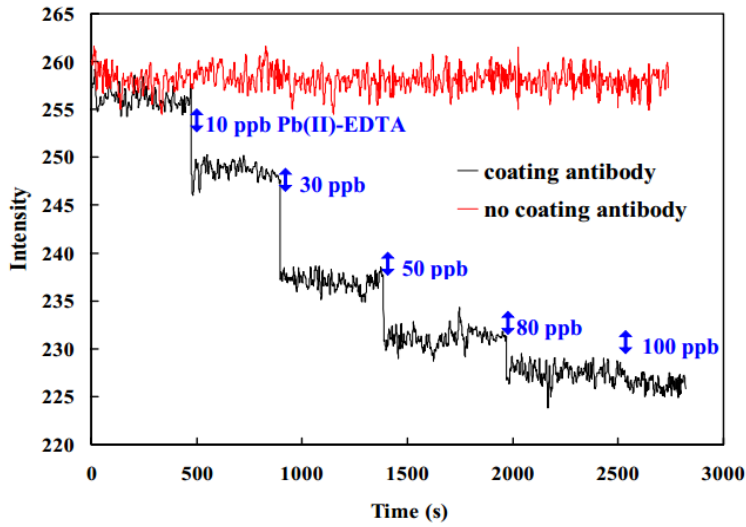
Figure 5. Difference in the response signal in the range of 10~100 ppb by two optical fiber sensors with antibody coating (black line) and without antibody coating (red line). Reprinted with permission of [15].